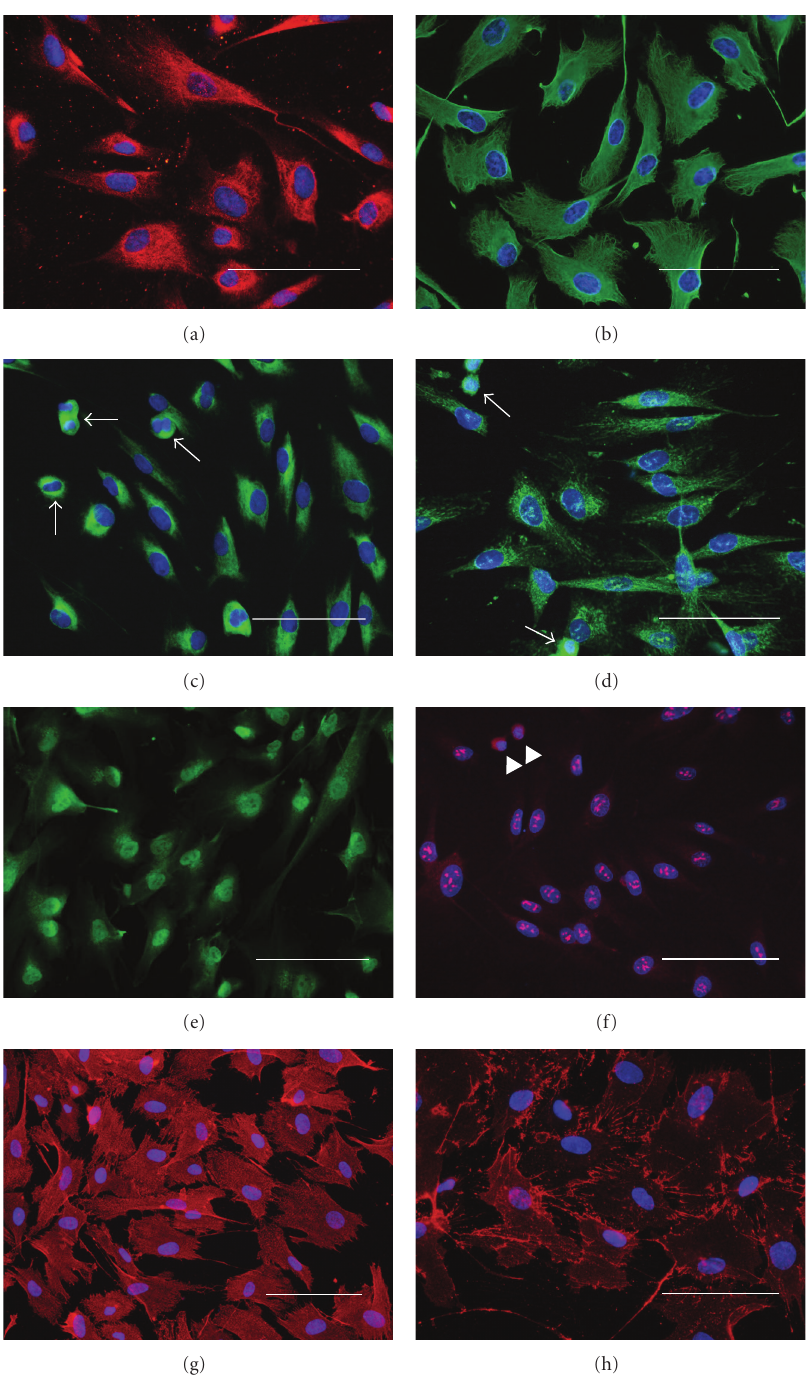
Figure 4: Immunocytochemical detection of analyzed markers in cultured DPSCs. (a) STRO-1 expression was readily detectable in all cells. (b) Immunostaining of vimentin revealed a regular filamentous cytoskeletal network within the cells with signal accentuation in perinuclear region. (c) Nestin expression appeared in the cell body, however, in cytoplasmic outgrowths the signal was lower but still distinguishable. Intensive signal is localized in dividing cells. (d) CXCR4 was localized mainly in the cytoplasm, namely, in its perinuclear area; some signal was also distinguishable within the cell nuclei. (e) Sox2 was distributed mainly in cell nuclei; signal in perinuclear cytoplasm likely reflects synthesis of this transcription factor in endoplasmic reticulum. (f) Nucleostemin was observed in nodular structures in cell nuclei; in mitotic cells or cells that had just finished cytokinesis (arrowheads) immunoreactivity was lost from the nucleus and distributed di ff usely. (g) CD90 immunofluorescence showed homogenous dot-like membrane staining pattern. (h) CD166 was localised in membrane of all DPSCs contouring the cell edges. Nuclei were counterstained with DAPI. Arrows indicate dividing cells. Scale bars 50 μ